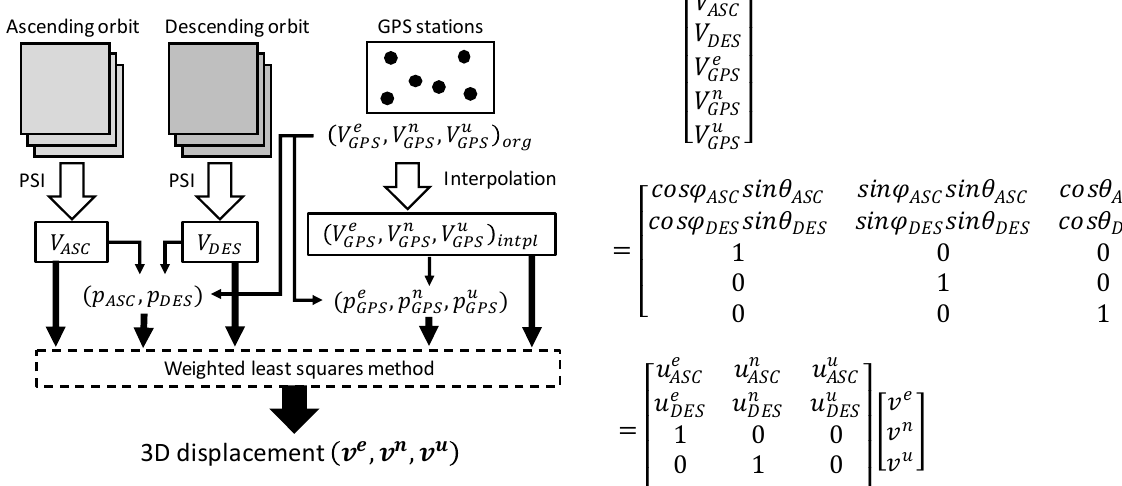
Figure 1. Flowchart of the proposed method for estimating 3D